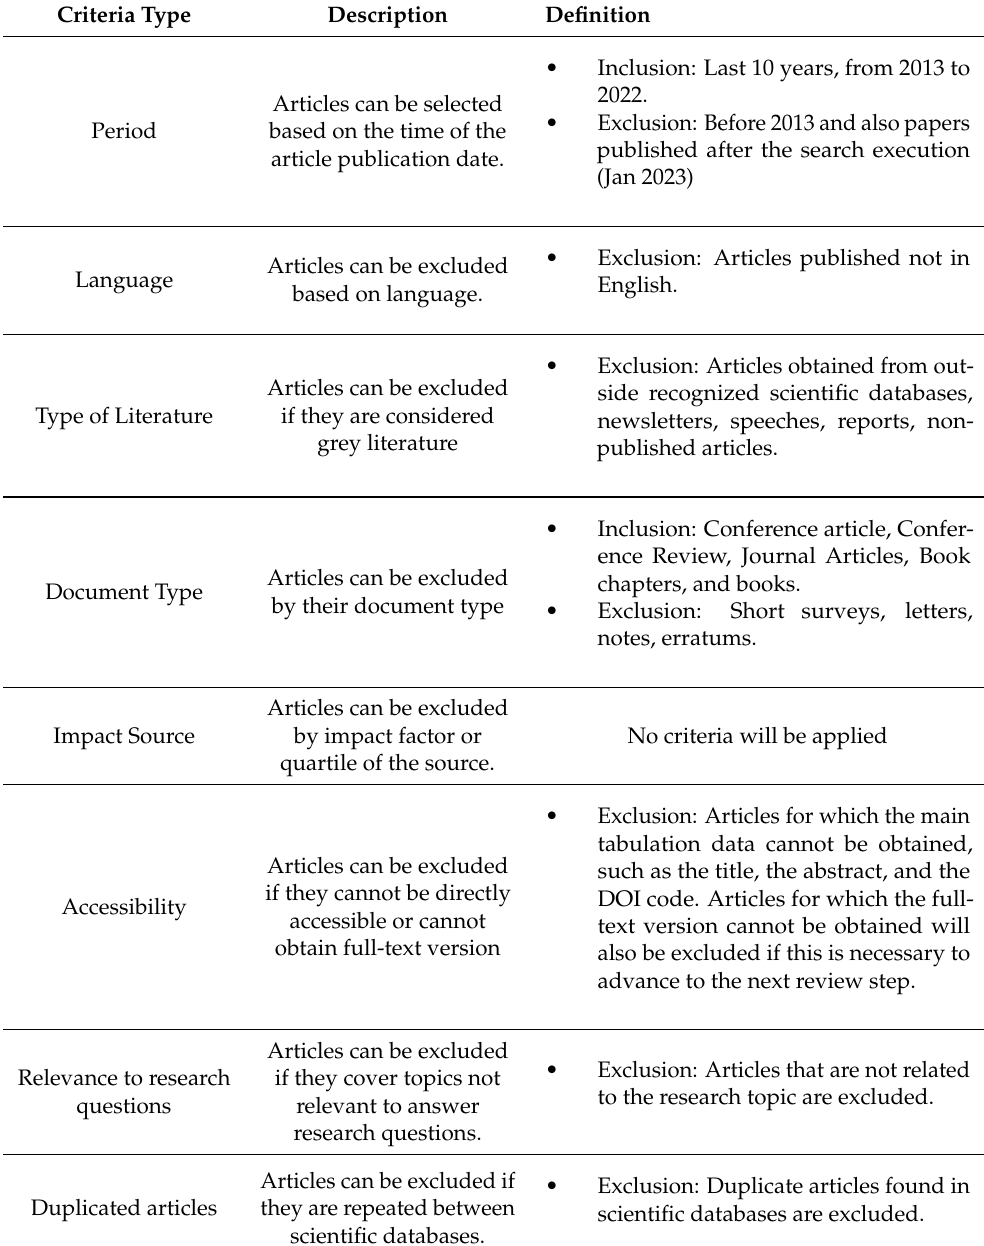
Table 4. Inclusion and exclusion